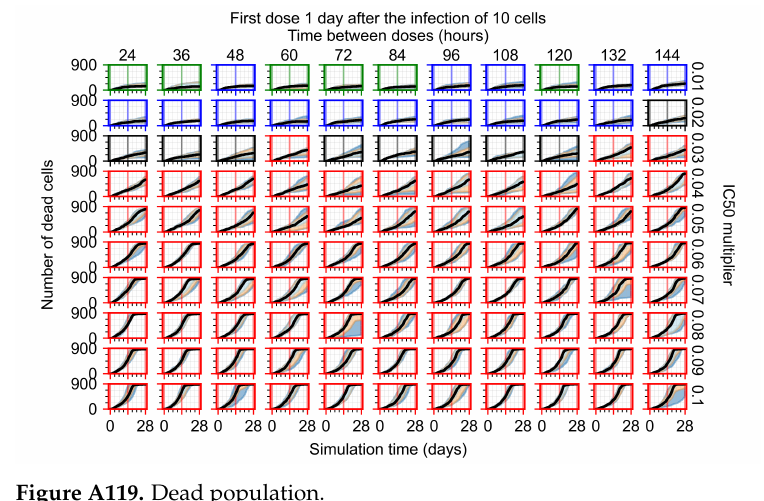
Figure A119. Dead population.